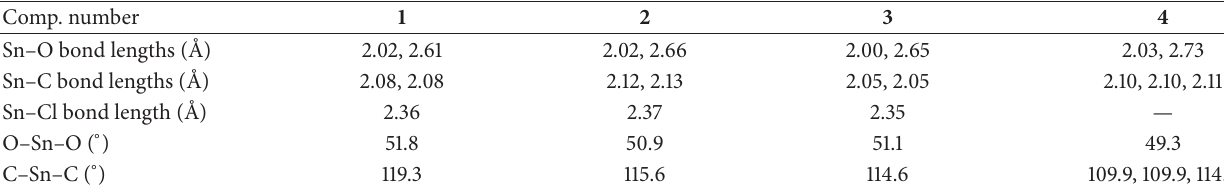
Table 7: Computed structural parameters of complexes 1–4 .